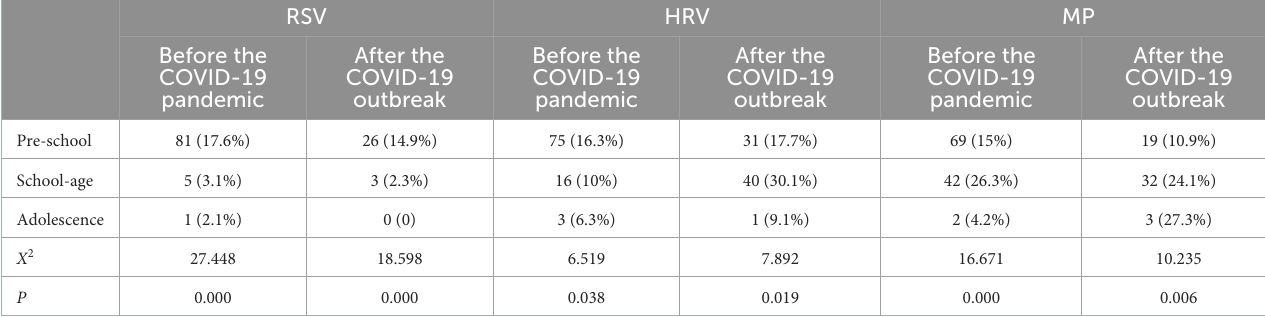
After the COVID-19